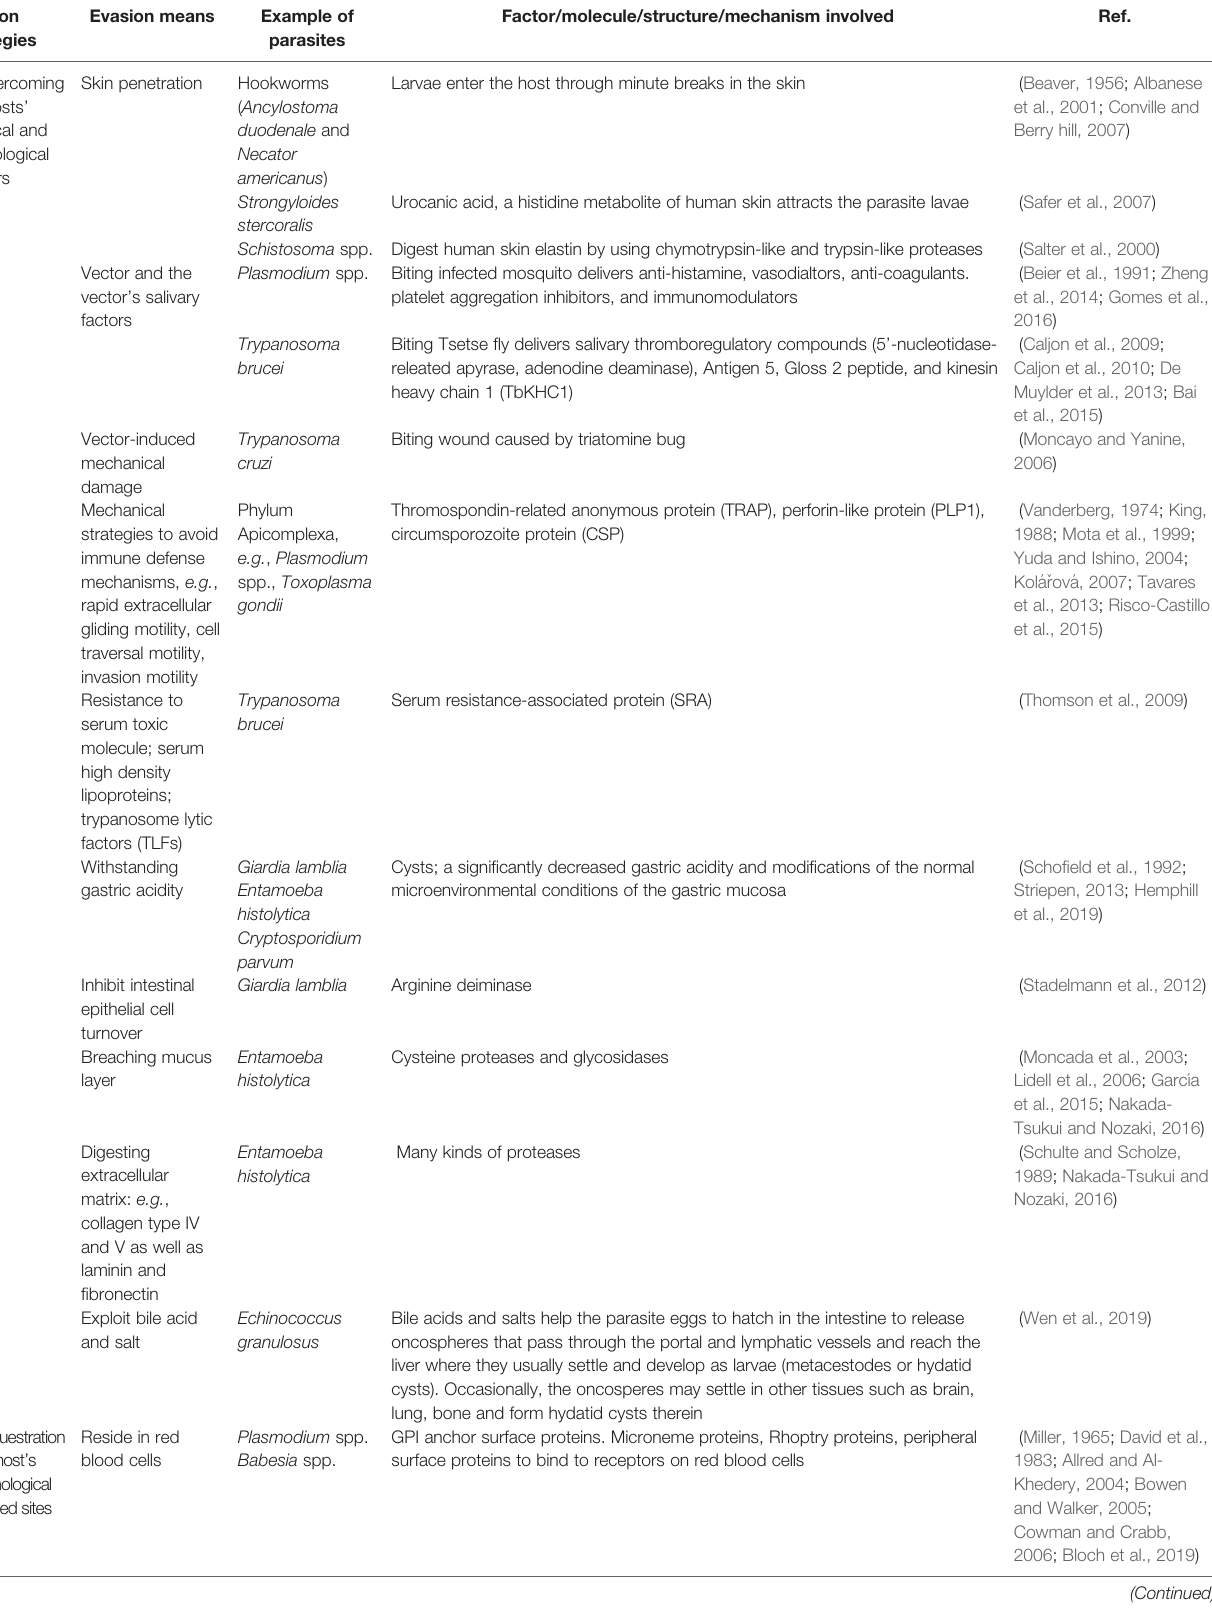
TABLE 2 | Strategies used by parasites to overcome, evade, and suppress host immunity. Evasion